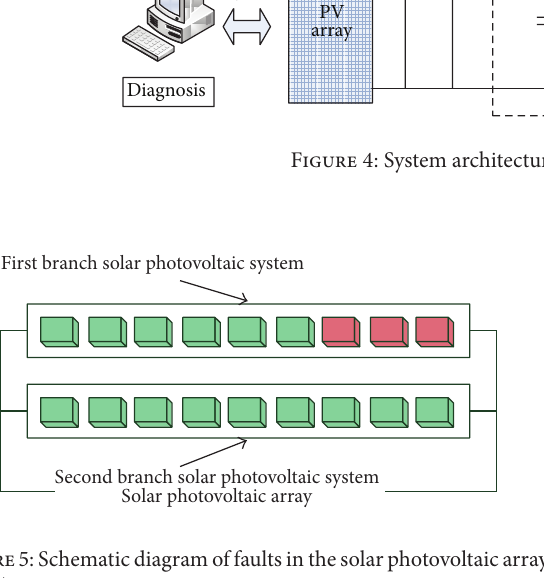
Figure 5: Schematic diagram of faults in the solar photovoltaic array (SCF 7